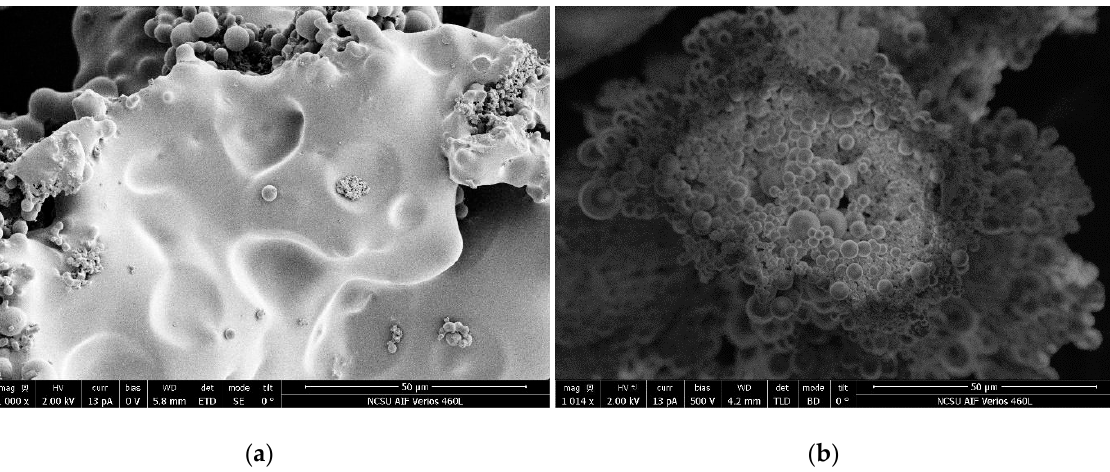
Figure 1. SEM images of cellulose nanofiber in water (CNF-W) hydrochar before and after rinsing with acetone, ( a ) Without acetone rinsing; ( b ) With acetone rinsing.